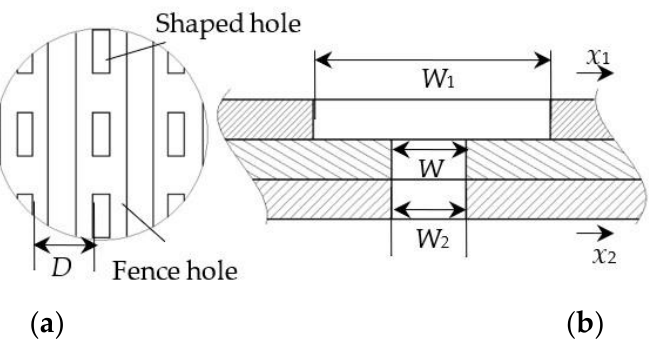
Figure 7. Key dimension diagram of seed-filling and discharging connection device: ( a ) Partial top view; ( b ) Partial front sectional view.